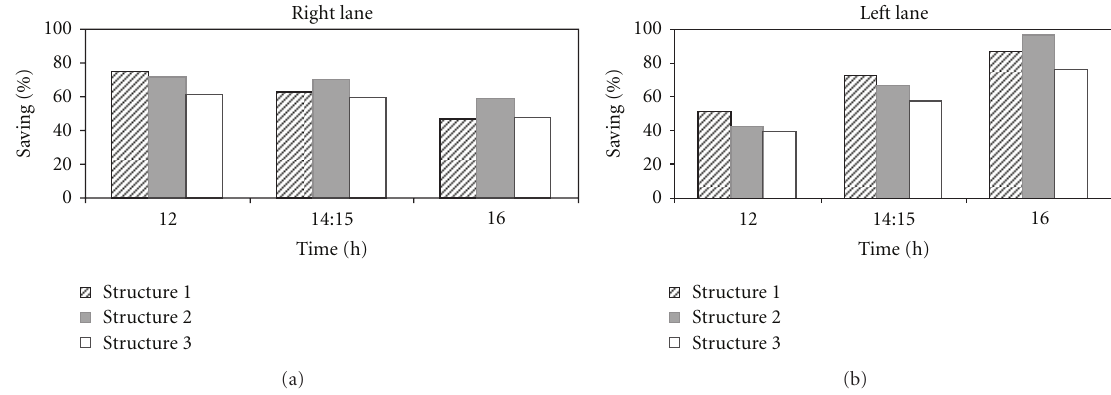
Figure 8: Energy savings in both lanes of the model tunnel for the three tension structures and the three peak hours.